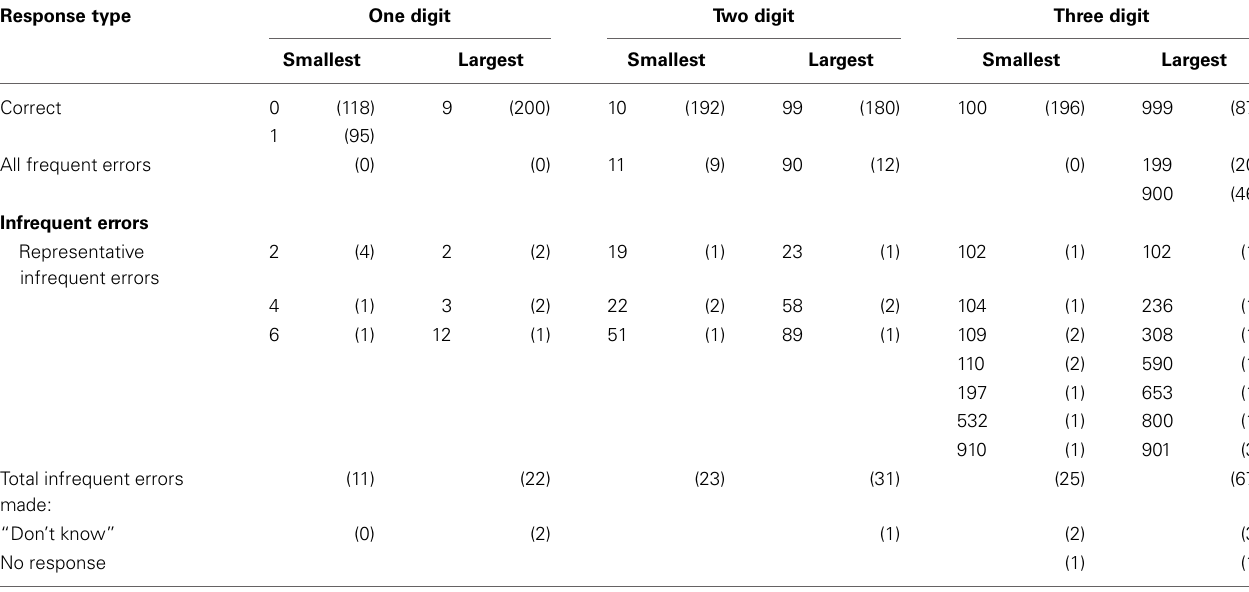
Table 2 | Classification (and counts) of 224 second graders’ responses showing correct responses, frequent errors, and a sample of infrequent errors* on individual Written Numbers Task items.